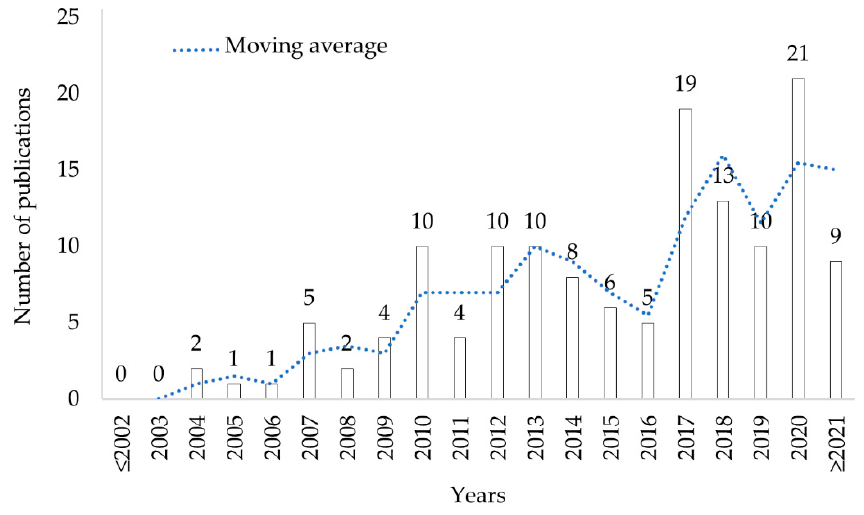
Figure 2. Evolution in precision coffee growing research publications from 2000 to 2021/1st sem.